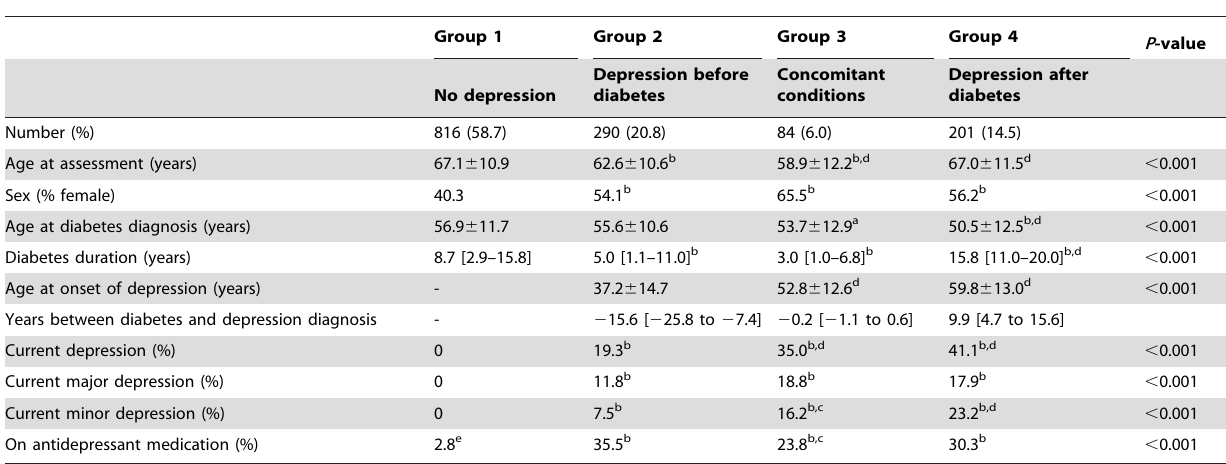
Table 1. 1,391 patients with type 2 diabetes grouped by depression